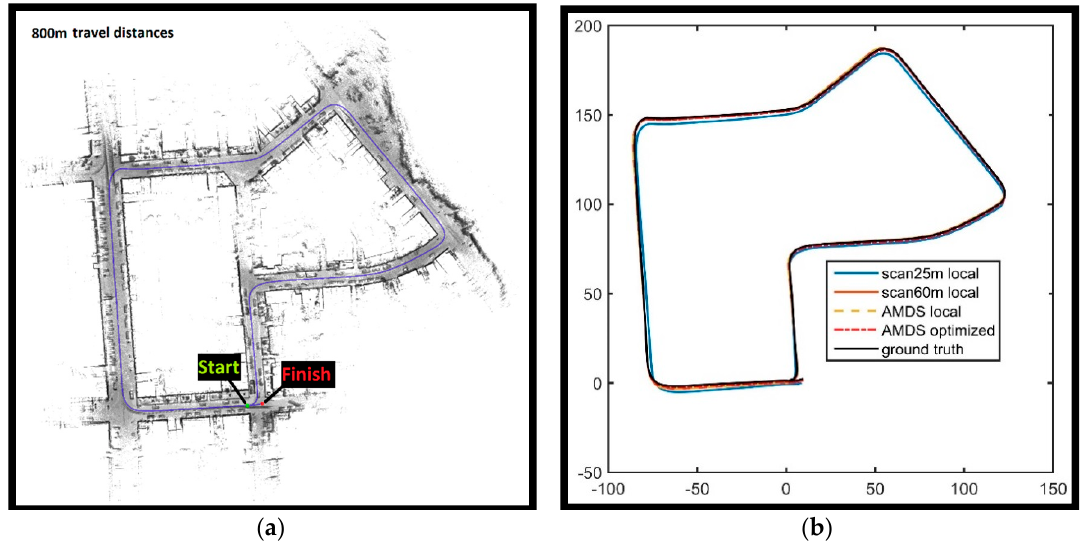
Figure 5. Trajectory results of the KITTI benchmark: ( a ) Map location and ( b ) trajectory results. In the KITTI benchmark, the AMDS (60 m/25 m) local SLAM achieves similar accuracy as compared with Cartographer (60 m scan) local SLAM. The Cartographer (60 m scan) local SLAM